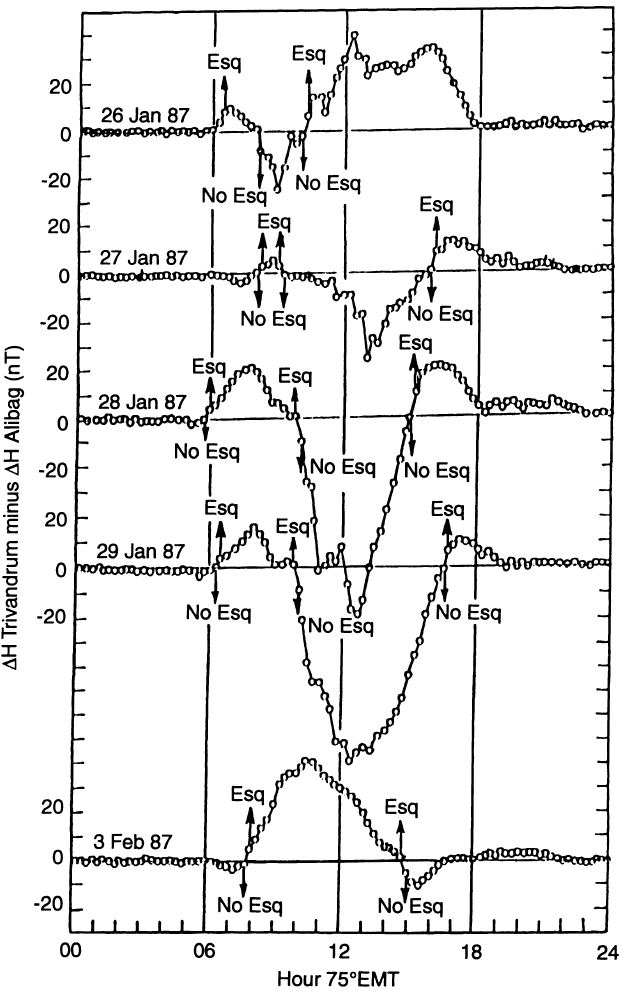
Fig. 10. Daily variations of the strength of equatorial electrojet, devoted by D H (Trivandrum minus Alibag), with the times noted for the appearance and disappearances of equatorial Es ( Esq ) for some of the days in January–February, 1987